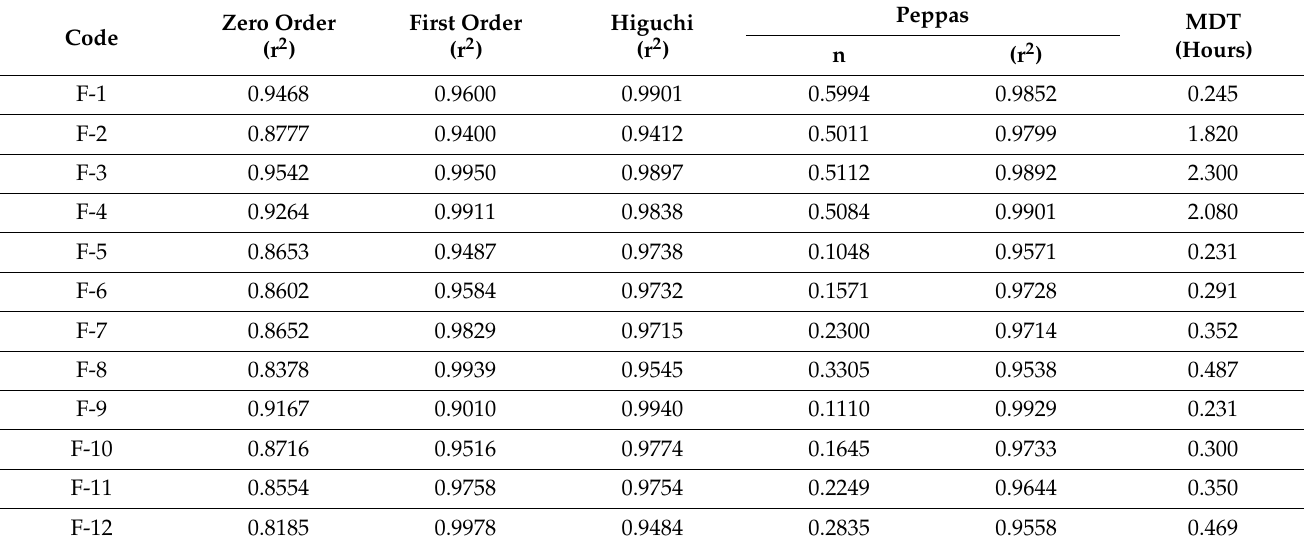
Table 3. Regression coefficient (r 2 ) values obtained from different kinetic models, diffusion exponent